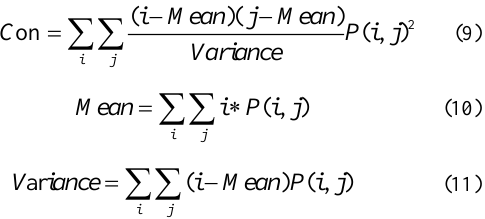
Figure 4. Non-background feature: (a) cloud image, (b) corresponding clear sky, (c) feature image obtained by subtracting (a) and (b)